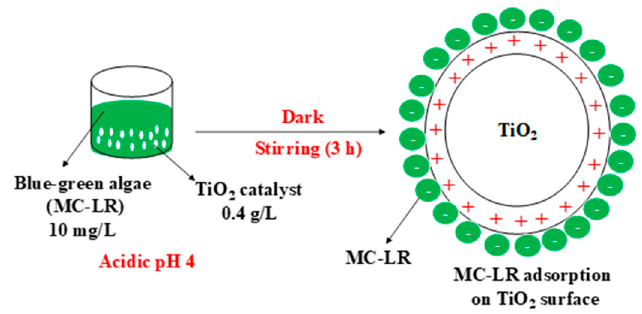
Figure 11. ( a ) Photodegradation of MC-LR with different initial concentration (10, 20, and 30 mg L − 1 ), using 0.4 g L − 1 CDT-0.00 under visible irradiation at pH 4; and ( b ) plot of C/C 0 vs irradiation time.